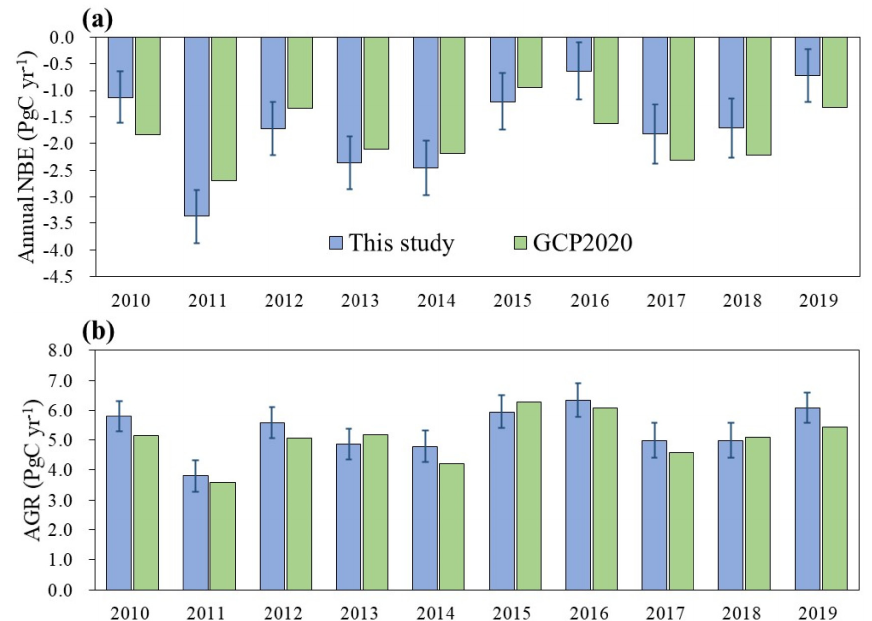
Figure 4. Comparisons between this study and GCP2020 for (a) NBE and (b) atmospheric growth rate (AGR); the NBE of GCP2020 is the sum of land sink and land-use change carbon emission, and the AGR of this study is the net flux as listed in Table 1.